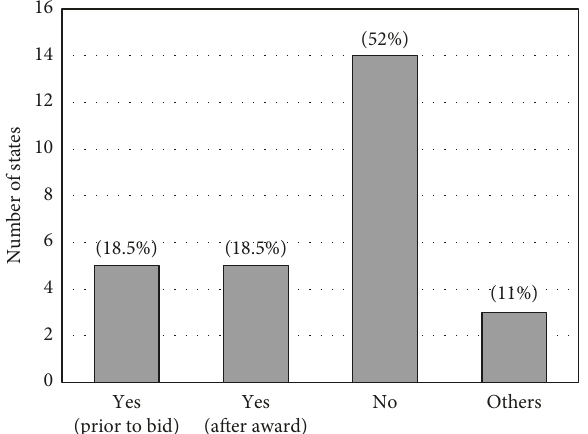
Figure 3: Number of states answering if agency has criteria, guidelines, or procedures for when a set of contract plans require the inclusion of demolition plan.